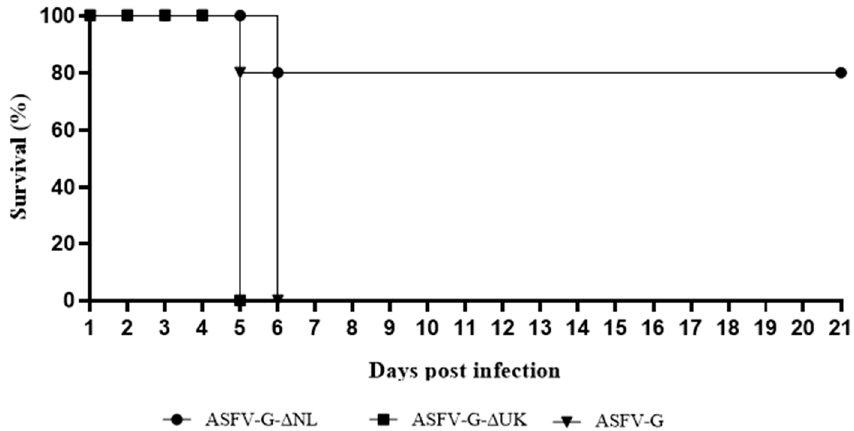
Figure 4. Evolution of mortality in animals infected with 10 4 HAD 50 of recombinant viruses ASFV-G- ∆ NL, ASFV-G- ∆ UK, or parental ASFV-G. Animals were monitored for an observational period of 21 days postinfection.